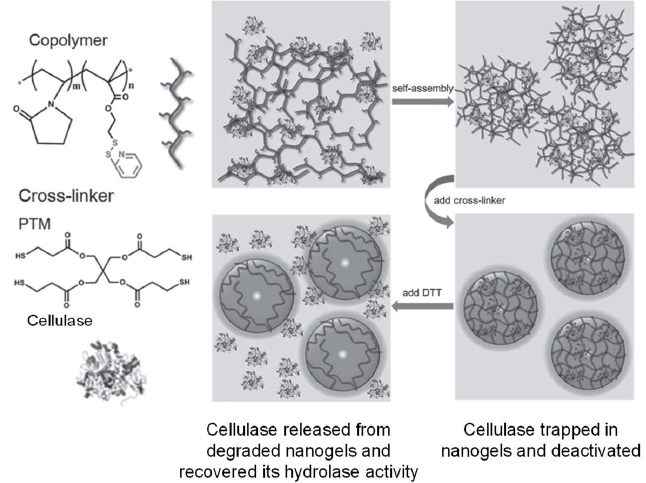
Figure 6. Crosslinking of pyridyl disulfide-presenting polymer self-assembly with thiol-terminated linkers for the encapsulation and deactivation of a cellulase. Image modified with permission from [42]. Copyright 2016 Wiley.